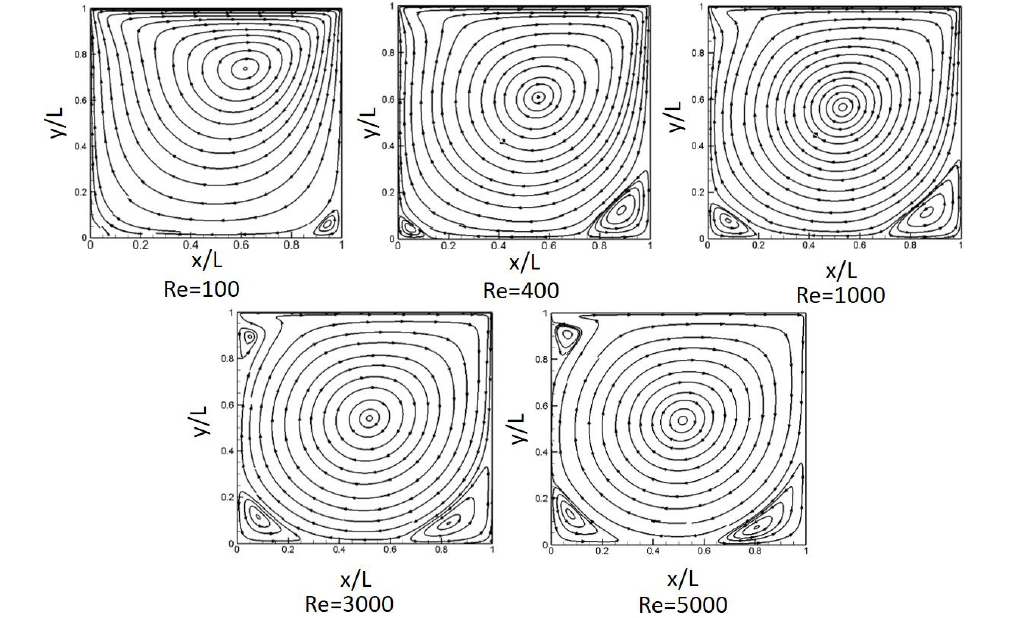
Figure 7. Streamline distributions with the changing Re